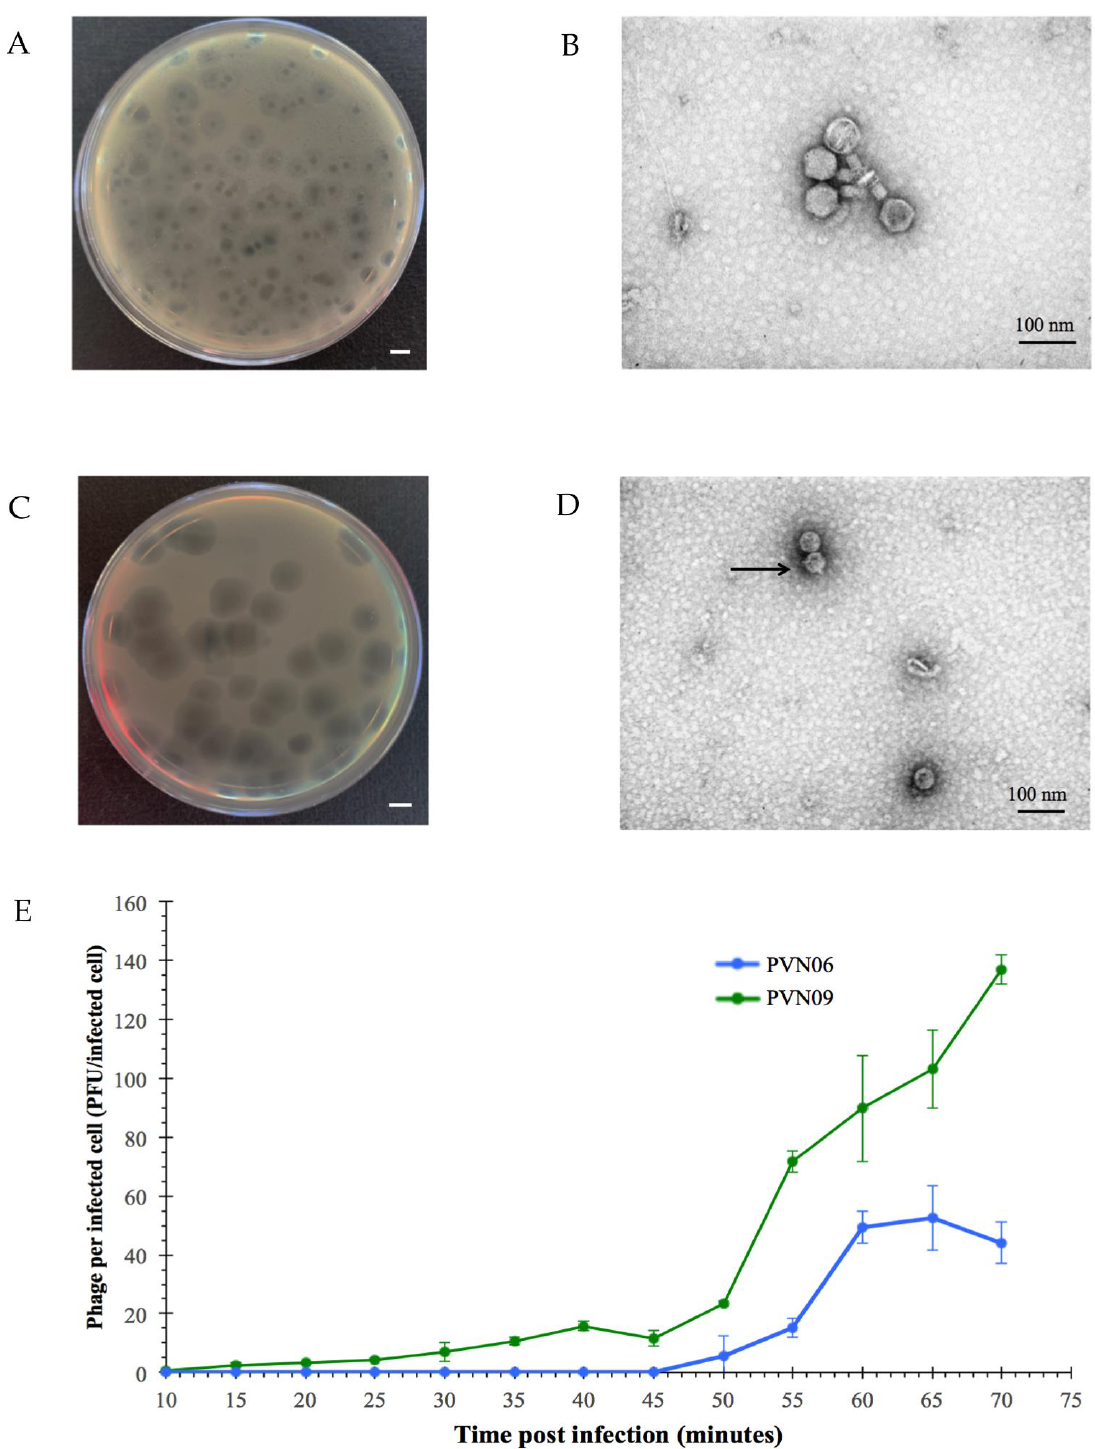
Figure 1. Characterization of Edwardsiella ictaluri phage PVN06 and PVN09. Top agar overlay showing plaque morphology of phage PVN06 ( A ) and PVN09 ( C ) on E. ictaluri E1. Scale bar indicates 1 cm. Transmission electron micrograph showing the tailed Myoviridae morphotype of PVN06 phage ( B ) and Podoviridae morphotype of PVN09 phage ( D ). The arrow indicates head structure of Podoviridae. ( E ) The one-step growth curves of the PVN06 phage (blue plot) and PVN09 phage (green plot) reveal progression of phage per infected cell over time with error bars showing standard deviation (SD). The values are means of three biologial repeats. The time period of 10 – 45 min was defined as eclipse period of PVN06 phage and the period of 10 – 50 min is for latency period of PVN09 phage. The burst period of PVN06 phage was defined as the time period of 45 – 70 min while the time interval of 50 – 70 min was defined for PVN09 phage.